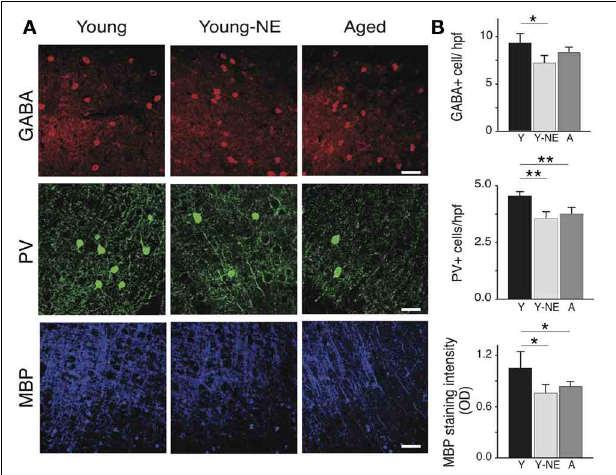
FIGURE 5 | Noise-induced changes in A1 PV + interneurons and myelin. Quantitative analysis of the average number in A1 of GABA and PV immunoreactive cells per high power field (hpf) and myelin basic protein (MBP) immunoreactivity in all experimental groups. (A) Representative high power photomicrographs of representative sections in all groups. (B) Average PV + and GABA + cell counts and average MBP staining fluorescence optical density in all groups (all layers averaged). Note the relative decrease in PV + cell count and MBP staining in Y-NE and A groups. Number of hemispheres examined: Y = 8, Y-NE = 8, A = 10. ∗ p < 0 . 05, ∗∗ p < 0 . 01: t -test. Scale bar: 50 µ m.